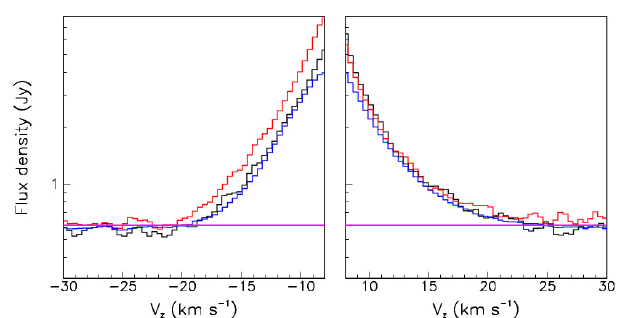
Figure 8: Doppler velocity distributions obtained for | V z | > 8 km s − 1 using two data sets of SiO line emission having significantly different uv coverage. The data set having the larger maximal recoverable scale is shown for R < 1.5 arcsec (red) and for R < 0.3 arcsec (blue). The data set having the smaller maximal recoverable scale is shown for R < 1.5 arcsec